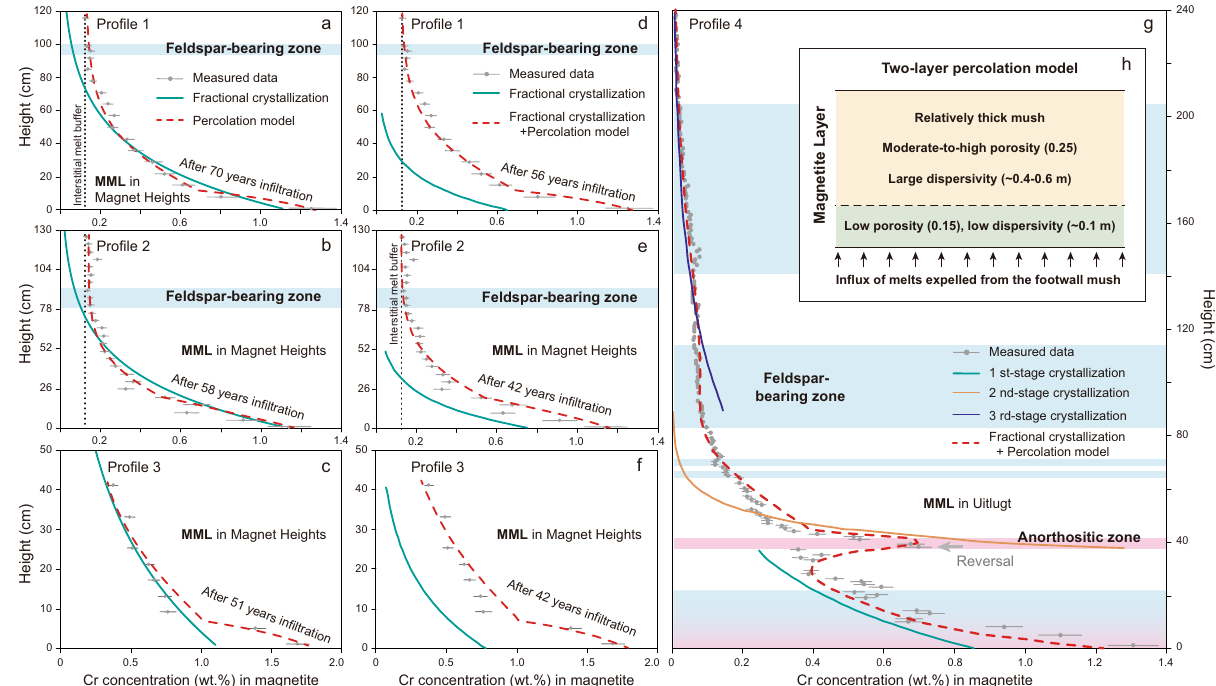
Fig. 1 Vertical pro fi les of Cr content in magnetitites. Previously published measured vertical pro fi les (1 – 4) of Cr contents in magnetite from the MML compared with results of our models conducted using parameters summarized in Table 1. Solid lines in a – c show trends resulting from various fractional crystallization models chosen to match the main parts of the pro fi les as well as possible; these fail to match the upper and basal parts of the pro fi les. Red dashed lines in a – c also show the effects of reactive melt in fi ltration from below the MML after hypothetical complete homogenization of the magnetite by re-equilibration with the overlying magma. It is possible to mimic the effects of fractional crystallization purely by reactive melt in fi ltration through a homogeneous mush pile. Solid lines in d – f show fractional crystallization trends chosen to permit subsequent reactive melt in fi ltration to modify them and bring them into line with the observed pro fi les (red dashed lines). In g reactive in fi ltration is imposed on a primary stack of magnetite mush recording three distinct episodes of fractional crystallization, with the fi rst at the bottom. h Diagram for the two-layer percolation model described in the text as reactive melt in fi ltration. All data were collected from multiple sources cited in the text, e.g., pro fi les in a , b , d , e 22 , c , f 18 and g 12